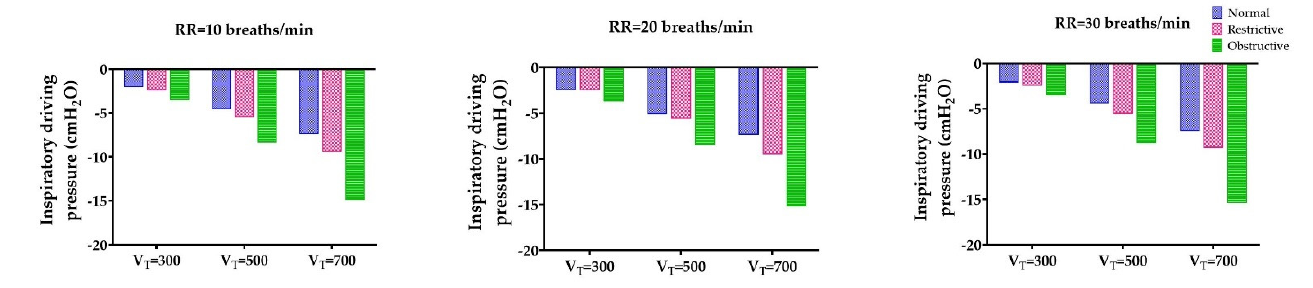
Figure 2. Effect of tidal volume (V T ) on inspiratory driving pressure.